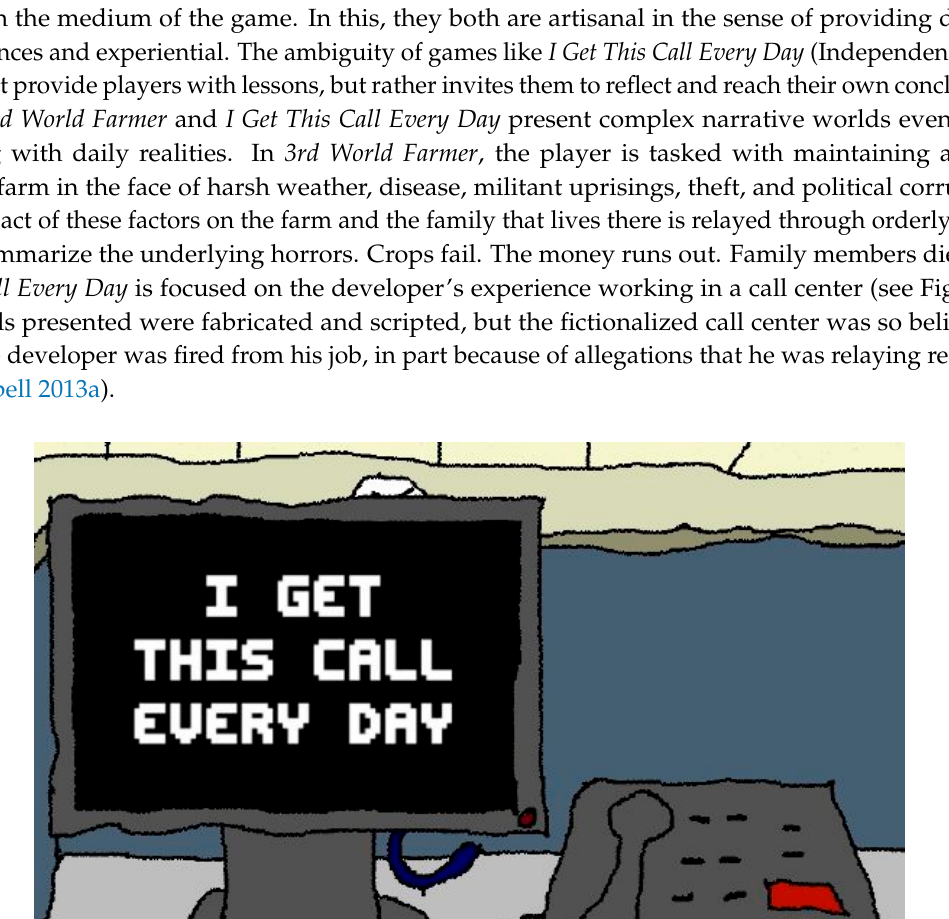
Figure 3. Depression Quest steadily eliminates options as the game unfolds.